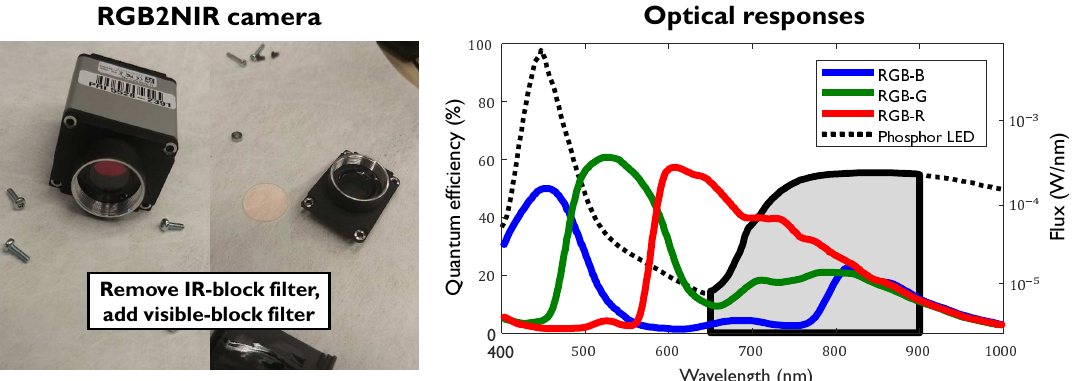
Figure 5. The multi-wavelength NIR camera unit RGB2NIR: ( Left ) the re-configuration of the RGB camera; and ( Right ) camera sensitivity profiles (red, green, and blue), illumination spectrum (dashed), and IR-passed spectral components (solid black line with gray area). The left y-axis denotes the quantum efficiency of camera, and the right y-axis denotes the Flux of Phosphor